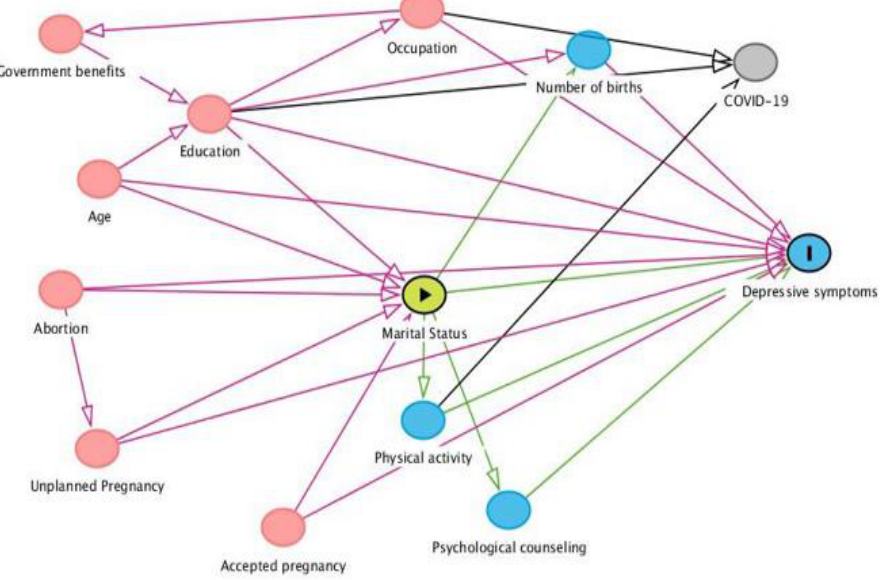
Figure 1. Theoretical model to assess the association of depression symptoms.